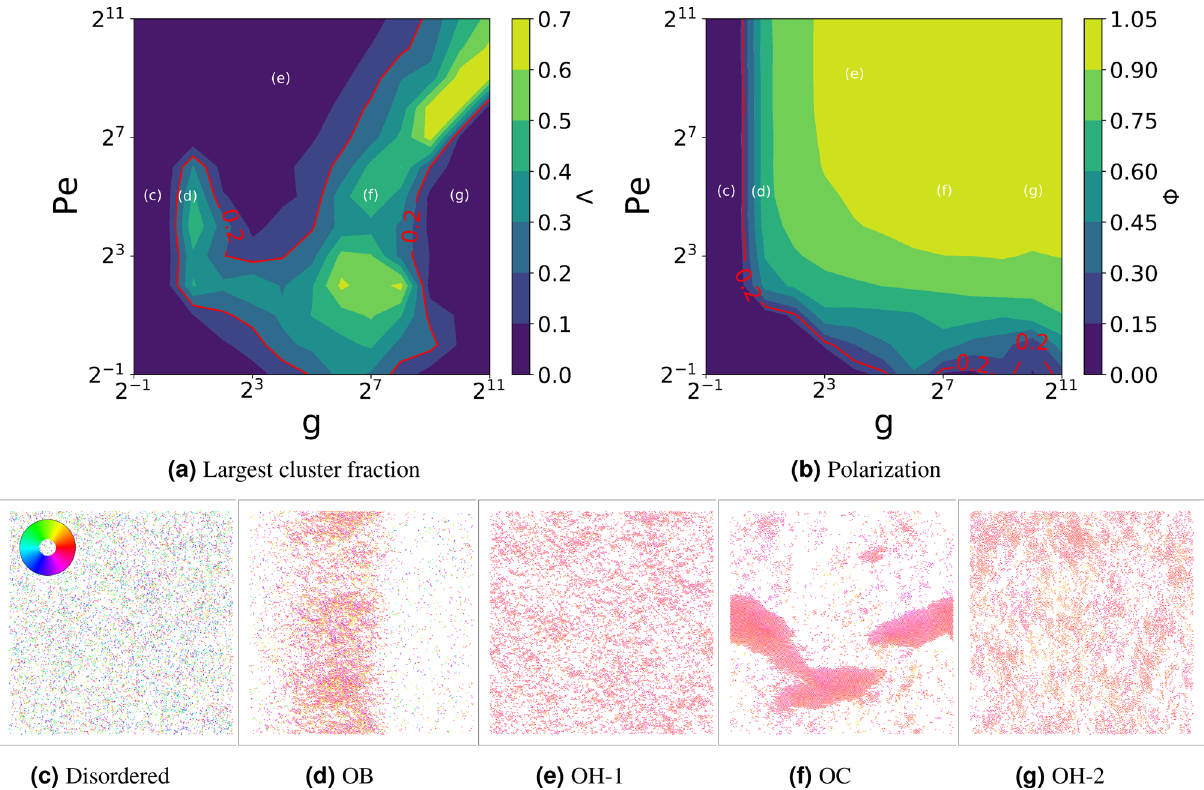
Figure 1. Spatial collective states of systems of self-propelled agents with alignment and repulsion. Top: Phase diagram as a function of Peclet number Pe and alignment strength g, showing the fraction of agents in the largest cluster (cid:31) ( a ) and the polarization (cid:31) ( b ). Bottom: Representative snapshots of the states labeled in panel ( a ). Disordered (Pe,g) = (32,1) ( c ); ordered with bands OB (Pe,g) = (32,2) ( d ); ordered homogeneous OH-1 (Pe,g) = (512,16) ( e ); ordered with clusters OC (Pe,g) = (32,128) ( f ); and a different ordered homogeneous state OH-2 (Pe,g) = (32,1024) ( g ). Each agent is colored by its heading angle, according to the color disk (top-left completeness. We find that, in general, the regions with highest degree of contagion tend to match the regions with highest clustering in Fig. 1a, and that they grow as (cid:31) or T inf are increased. The central panels shows that, for an intermediate (cid:31) = 2.0 value, the region with high epidemic spreading matches almost exactly the high clustering regions OB and OC in Fig. 1, although some simulations with rela- tively high level of contagion can also be found in the disordered region. The top right panel shows that, for a very high (cid:31) = 100 , almost the whole phase space displays high levels of epidemic spreading, with the homogeneously ordered (OH) regions presenting the lowest levels. The bottom row shows that we obtain equivalent results if we instead vary T inf , but with larger ρ R ( ∞ ) differences between the regions with high and low epidemic spreading. Figure 3 provides a more detailed view of the effectiveness of each epidemic outbreak and its onset points, plotting ρ R ( ∞ ) as a function of (cid:31) and T inf for the five collective states identified in Fig. 1. Each point displays the mean value obtained for the 50 simulations performed per parameter combination and the error bar shows the corresponding standard deviation. Panel (a) confirms that outbreak onsets occur at the lowest (cid:31) ≈ 0.5 values in the inhomogeneous (OB, OC) states and at higher (cid:31) ≈ 1 values in the homogeneous disordered (D) and homogeneous ordered (OH-1, OH-2) states. The value of ρ R ( ∞ ) then increases with (cid:31) at a different rate for each case. At an intermediate (cid:31) ≈ 10 , we find that the OB state has the highest mean ρ R ( ∞ ) , followed closely by the OC and disordered states. For very large (cid:31) (cid:31) 200 , the disordered and OB states display the highest, very similar ρ R ( ∞ ) ≈ 0.8 values, whereas the OC case seems to saturate at a slightly lower level. Instead, both OH states display a significantly lower level of epi- demic spreading, with a fraction of recovered agents ρ R ( ∞ ) ≈ 0.3 that is slightly higher for OH-1 than for OH-2. Panel (b) shows that the outbreak onsets occur at very different T inf levels in the disordered, OH-1, and OH-2 states (order 10 1 , 10 2 , and 10 3 , respectively). These three homogeneous states eventually reach high infection levels, but only for very high T inf values. This panel also shows that, in the (cid:31) = 2 case considered here, states OC and OB develop high levels of infection for all T inf values. Even at a very low T inf = 10 − 2 we find that, remarkably, they still display significant outbreaks, with ρ R ( ∞ ) (cid:31) 0.4 . In the opposite limit, for a very high T inf = 10 4 , both converge to a similar state of full epidemic spreading, with ρ R ( ∞ ) ≈ 1 .